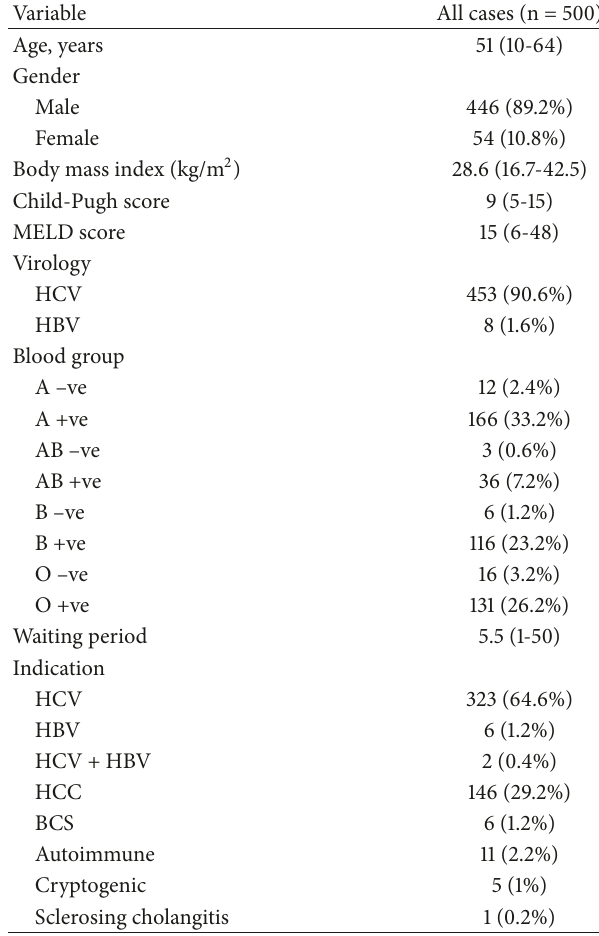
Table 1: Demographic data of the study